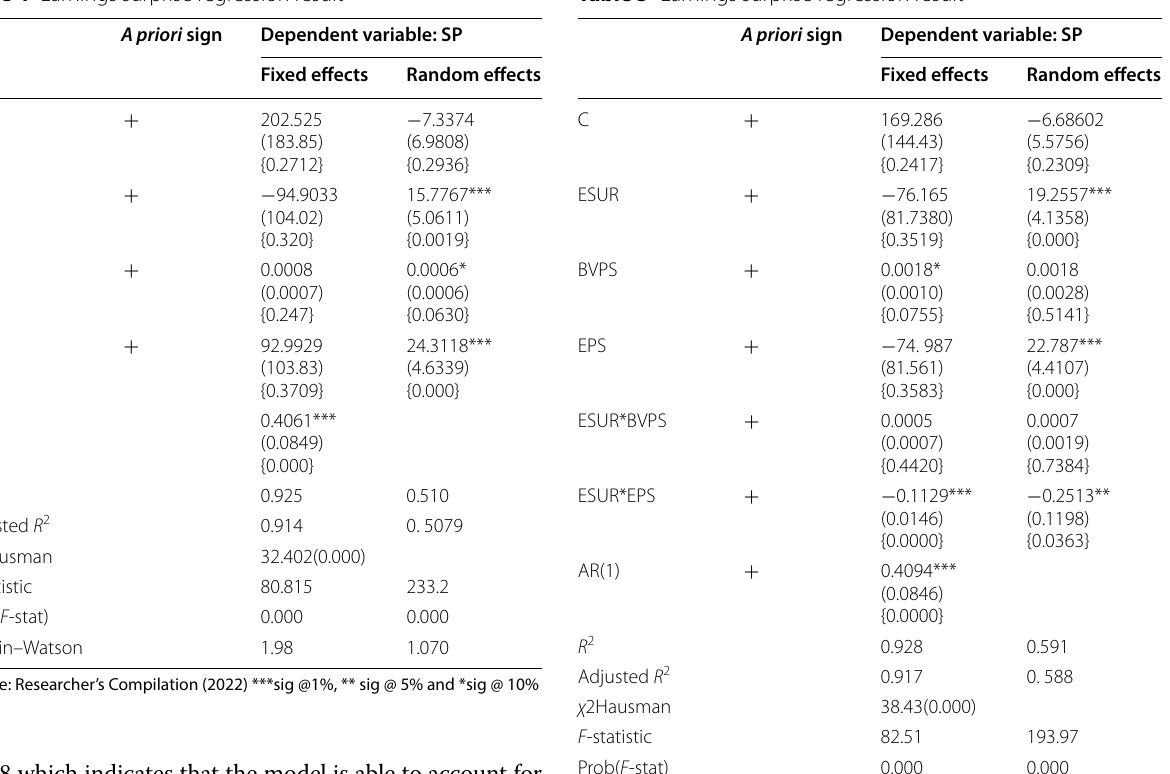
Table 4 Earnings surprise regression result Table 5 Earnings surprise regression